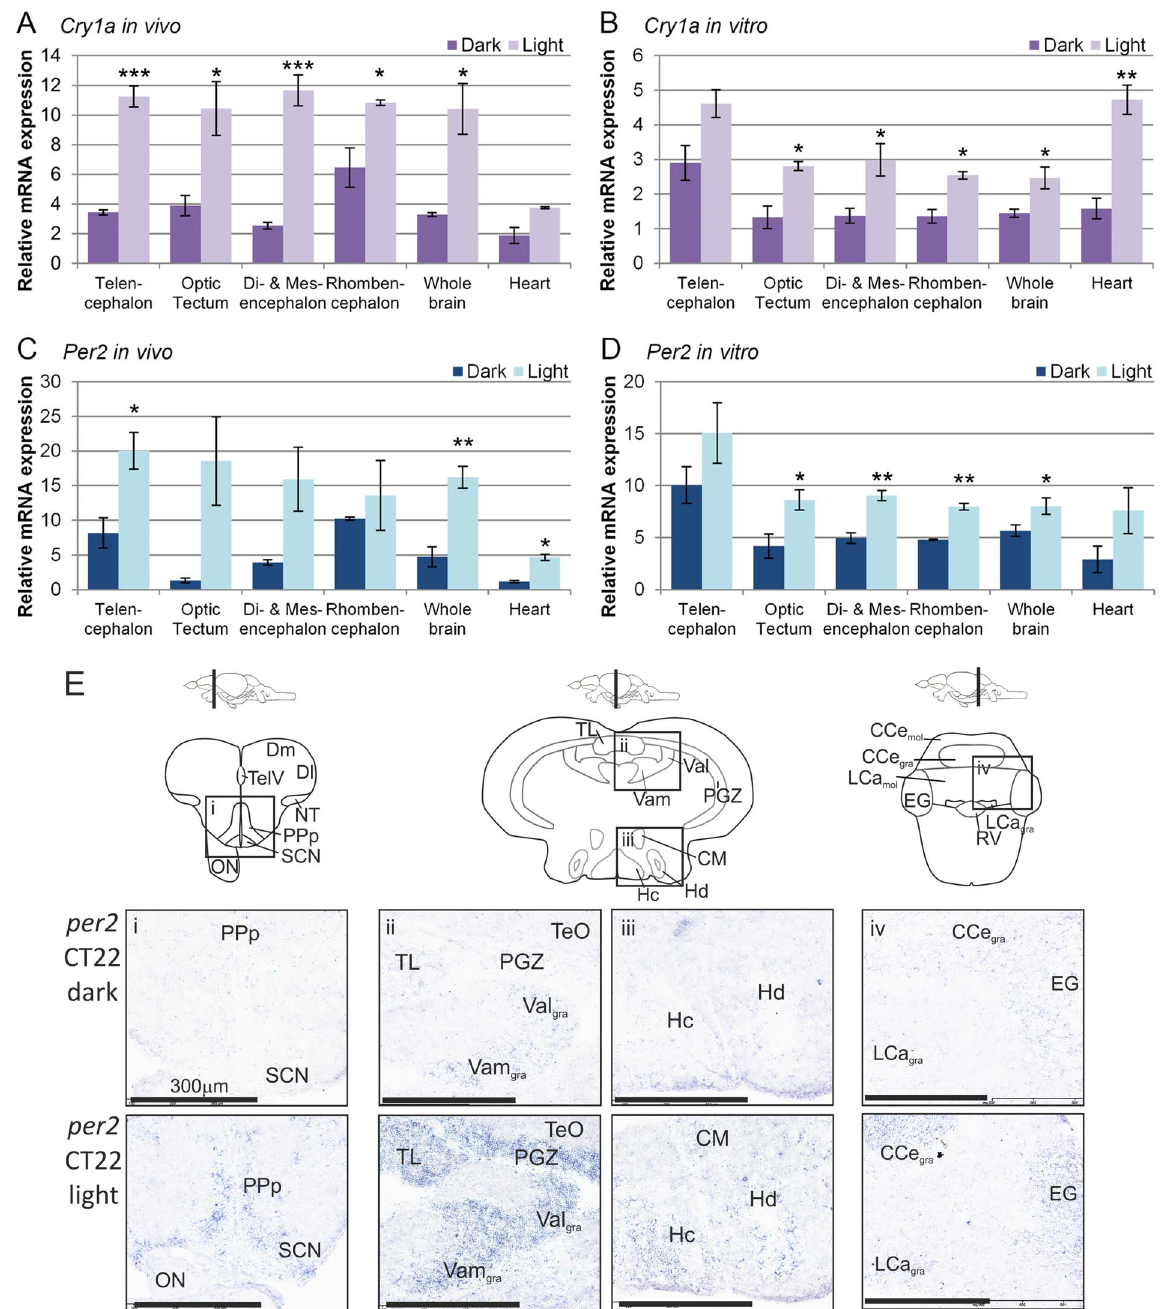
Figure 4. Expression of light sensitive genes, cry1a and per2 , in the adult zebrafish brain. A & C) Wild type adult zebrafish were kept in the dark for 3 days and then either exposed to light for 3 hours or remained in the dark. The zebrafish were killed at CT22 and their brain and hearts dissected, RNA extracted and qPCR performed. The majority of samples collected from different brain regions showed the light responsive genes, cry1a and per2 , were increased in light pulsed tissues compared to dark control. Numerous brain parts showed an increase in cry1a and per2 in the light pulsed samples (p , 0.0001 and p=0.0015 respectively, Two way ANOVA, n=3). The light pulsed zebrafish had significantly higher c ry1a and per2 levels in both the heart and brain (p , 0.002, Two way ANOVA, n=3). B & D) Wild type adult zebrafish brain parts, whole brains and hearts were cultured in L15-media for four days. Samples were exposed to a 3 hour light pulse or kept in the dark and collected at CT22, RNA extracted, and qPCR performed. Cry1a and per2 is induced by light in both the brain and heart (p , 0.0001, Two way ANOVA, n=3–5). The light pulsed brain part cultures had significantly higher cry1a and per2 levels than the dark controls (p , 0.0001 and p=0.0013 respectively, Two way ANOVA, n=3). E) Wild type adult zebrafish were kept in the dark for 3 days and then either exposed to light for 3 hours or remained in the dark. The zebrafish were killed at CT22 and their brain dissected, fixed, frozen and sectioned. Chromogenic in situ hybridisation was performed to determine the location of per2 mRNA expression. There was minimal or undetectable expression in the dark samples. In the light pulsed samples expression of per2 was increased in the i) PPp and SCN, ii) PGZ, TL, Val gra and Vam gra , iii) Hc and Hd, iv) EG, CCe gra , and LCa gra .